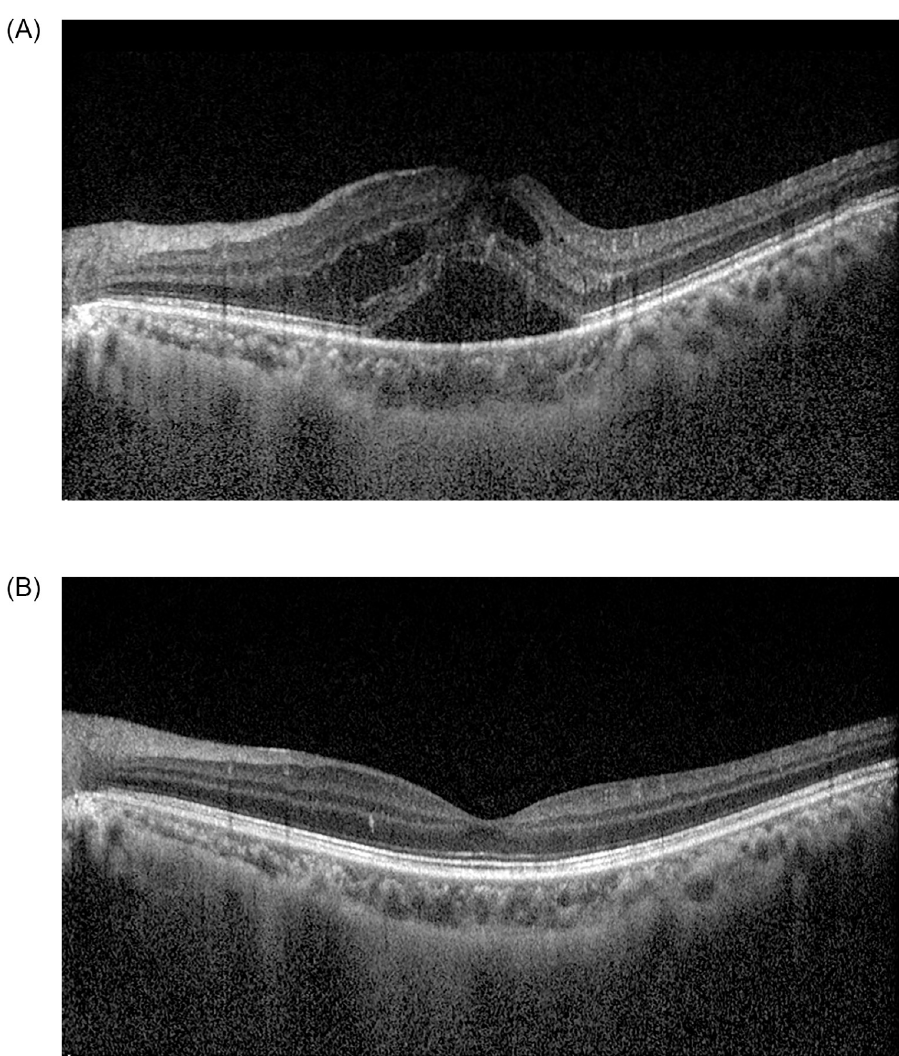
Fig 2. A 40-year-old male patient with branch retinal vein occlusion in the right eye. He had a history of dyslipidemia. At the time of diagnosis, best-corrected visual acuity (BCVA) was 0.3 logMAR in the left eye. A fundus examination revealed flame-shaped retinal hemorrhage and cotton-wool spots along the superotemporal vascular arcade in the left eye. The central macular thickness (CMT) was 586.0 μ m in the left eye (A). One month after intravitreal bevacizumab injection, BCVA in the left eye improved to 0.2 logMAR. The retinal hemorrhages improved, and CMT decreased to 286.0 μ m in the left eye (B). The aqueous endothelin-1 level was 12.8 pg/mL at the time of the first intravitreal bevacizumab injection, and then decreased to 1.7 pg/mL one month after injection.